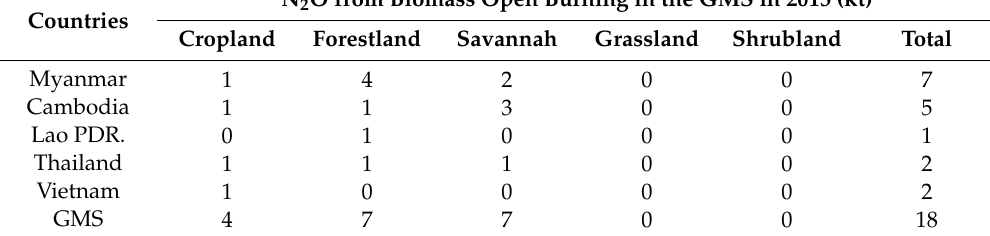
Table A3. The actual amount of N 2 O from biomass open burning classified by vegetation types in the GMS in 2015.